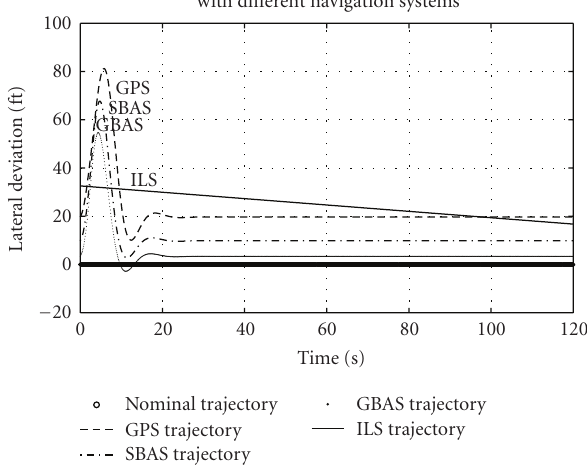
Figure 8: Lateral positioning comparison among di ff erent naviga- tion systems.